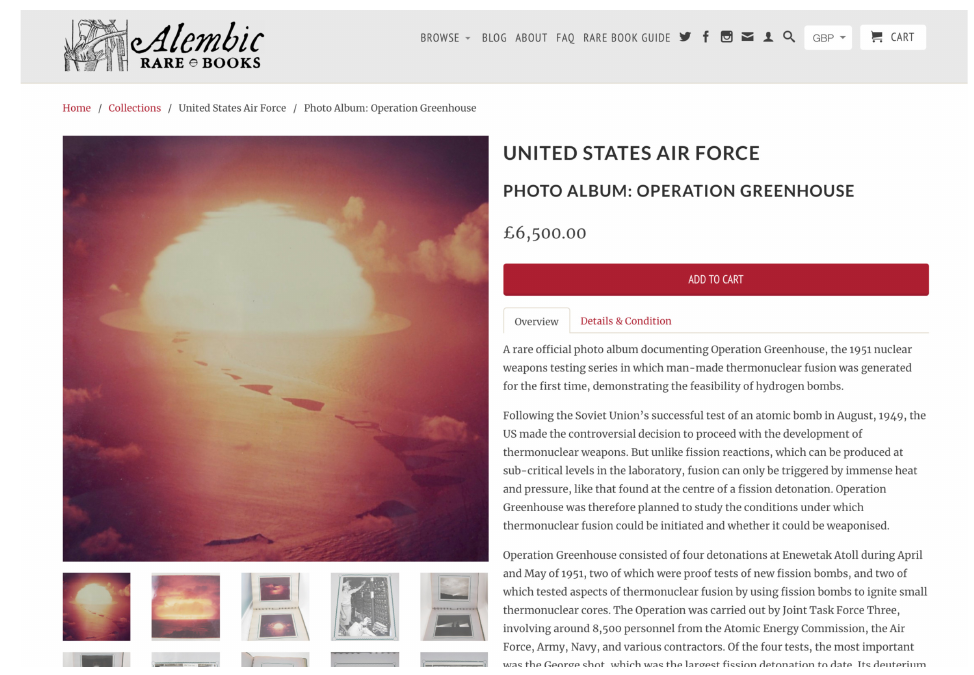
Figure 3: Screenshot of online auction for Operation Greenhouse photo album, 2018. Image courtesy of the